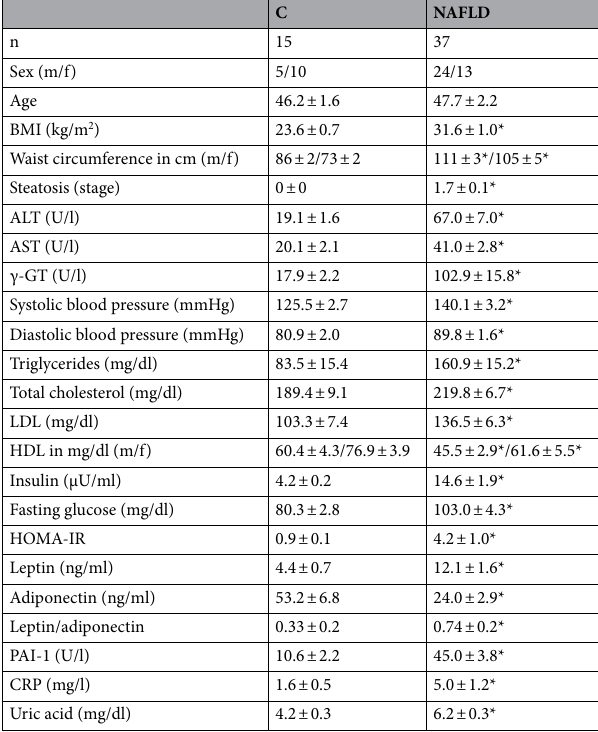
Table 1. Characteristics of study participants. Data are shown as total numbers and means ± SEM, respectively, n = 14–15 controls and n = 32–37 NAFLD patients, * p ≤ 0.05 compared to controls. γ-GT gamma glutamyl transferase, ALT alanine aminotransferase, AST aspartate aminotransferase, BMI body mass index, C healthy controls, CRP C-reactive protein, NAFLD patients with non-alcoholic fatty liver disease, PAI-1 plasminogen activator inhibitor